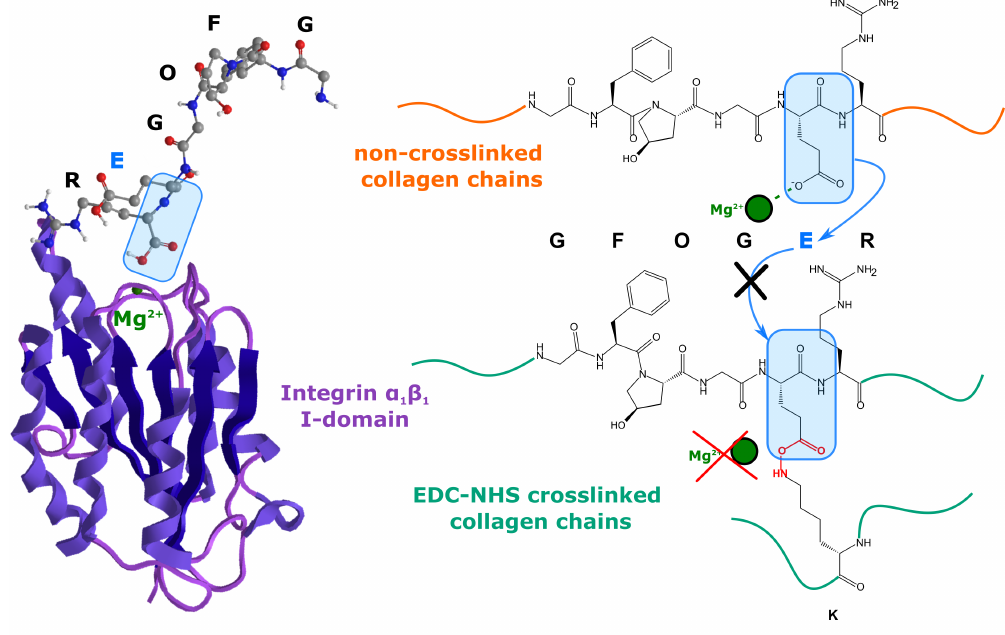
Figure 3. Mechanism of integrin adhesion loss through EDC-NHS crosslinking. The I-domains of integrins coordinate to collagen through a divalent cation (Mg 2 + ), which is supported by the glutamic acid residue in the GXOGER MIDAS motif (GFOGER variant illustrated here). The formation of the peptide bond between glutamic acids (E) and lysines (K) is suggested to be the origin of the observed loss of integrin-specific attachment to EDC-NHS crosslinked collagen. Adapted from Bax et al.